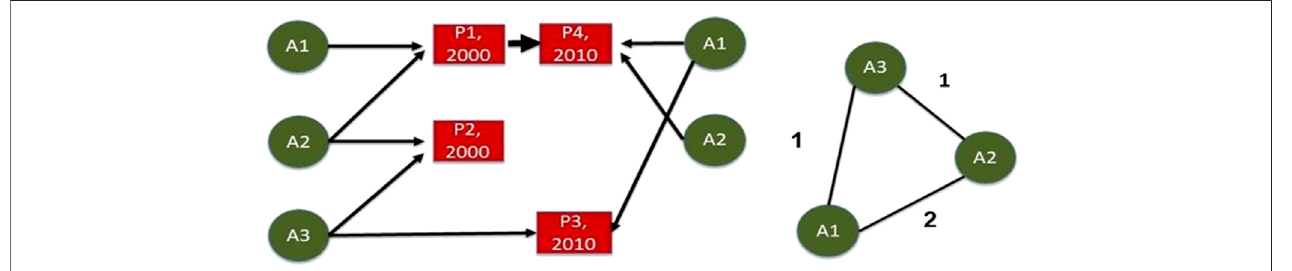
FIGURE 2 | Illustration of co-authorship links shows three authors and four documents over time (left), and the construction of authorship networks using full counting (right).